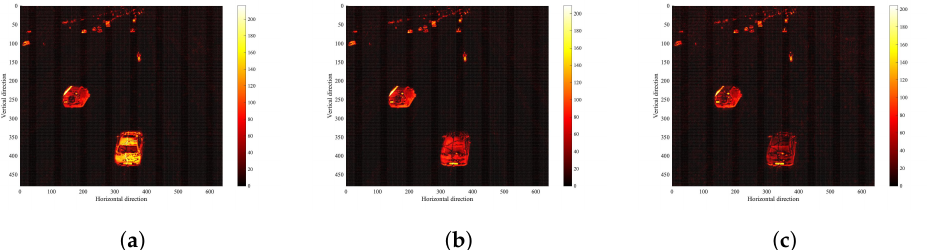
Figure 7. The mapped result of background subtraction under ( a ) red mode, ( b ) green mode, and ( c ) blue mode.